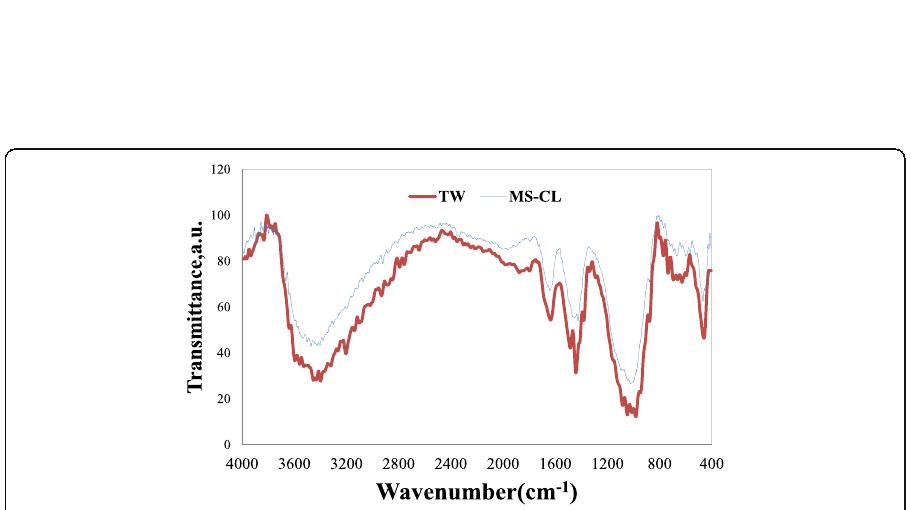
Fig. 14 I.R. spectra of GPCB100 samples under ACS with different aggressive media